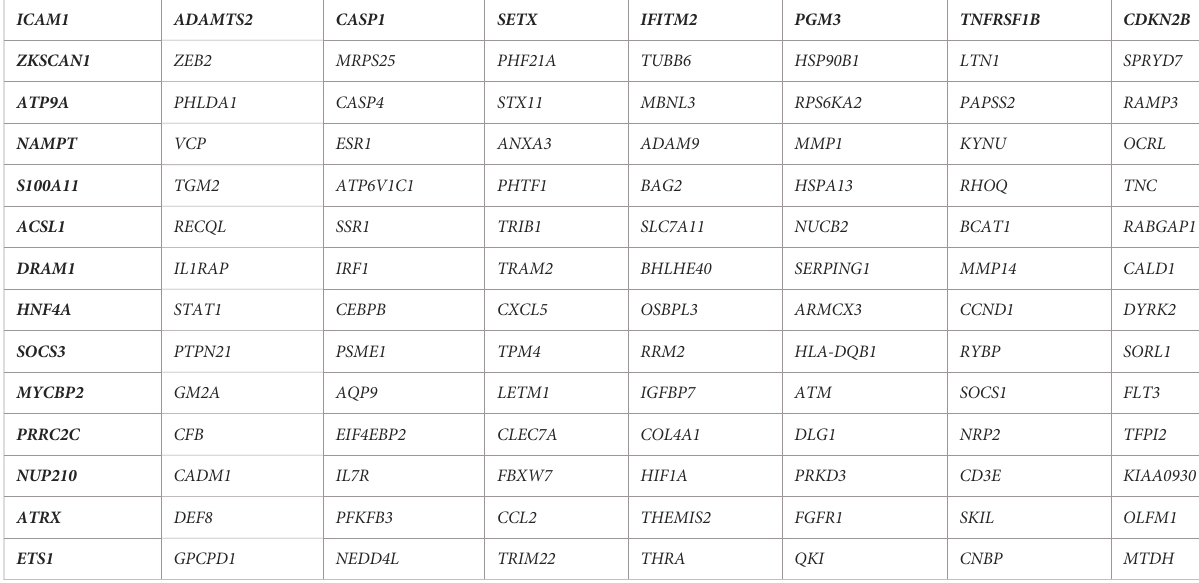
TABLE 3 Genes comprising the M1 co-expression